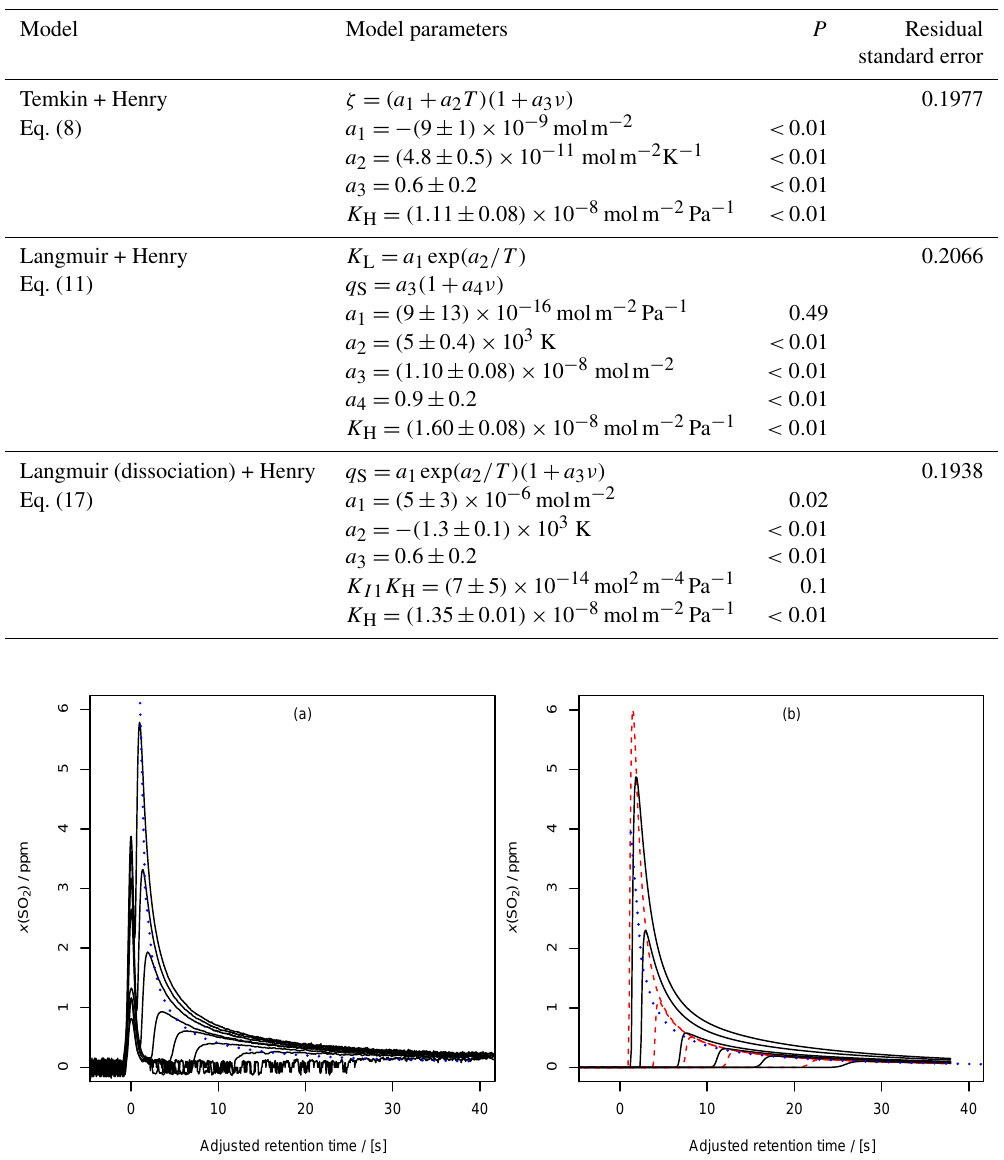
Figure 2. (a) Chromatograms from injection of various amounts of a SF 6 / SO 2 mixture at 247K and 2µm ice film thickness. (b) Simulated SO 2 chromatograms using the Temkin isotherm with ζ = 4 . 3 × 10 − 9 molm − 2 , K T = 10 − 6 molm − 2 Pa − 1 and K H = 2 . 8 × 10 − 9 molm − 2 Pa − 1 using 100 cells in an axial direction. Dashed lines: simulation without absorption/diffusion into the solid phase. Solid lines: simulation including diffusion into the solid phase with H = 50 and D s = 2 × 10 − 13 m 2 s − 1 using 30 cells in a radial direction. The dotted lines are calculated with Eq. (1). They represent the locations of the experimental peak